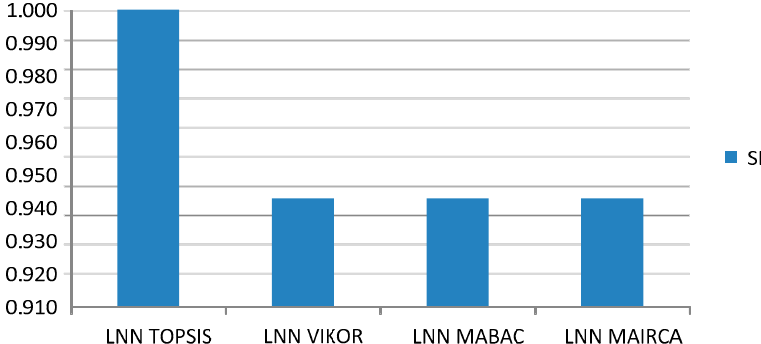
Figure 6. Values of the Spearman coefficient for VKO models.